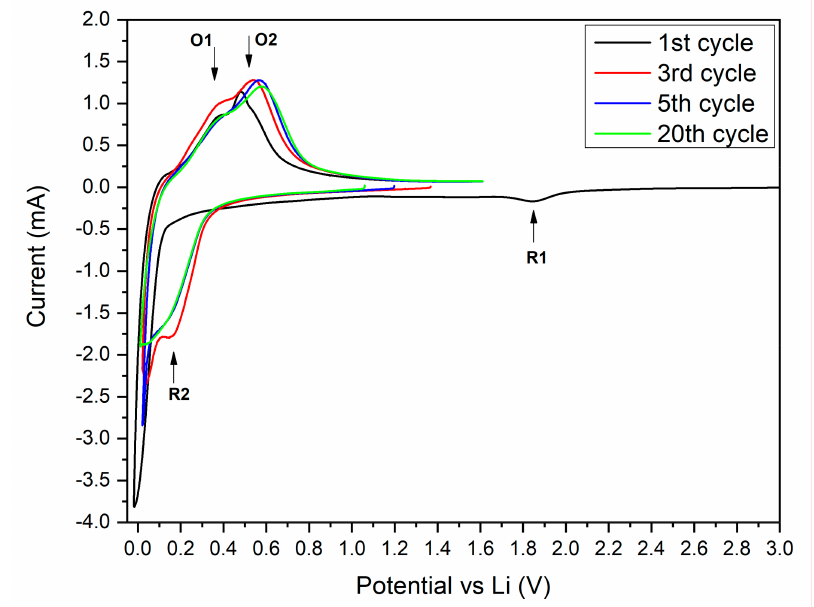
Figure 4. Cycle voltammetry of Si-1 electrode in cycle 1, 3, 5 and